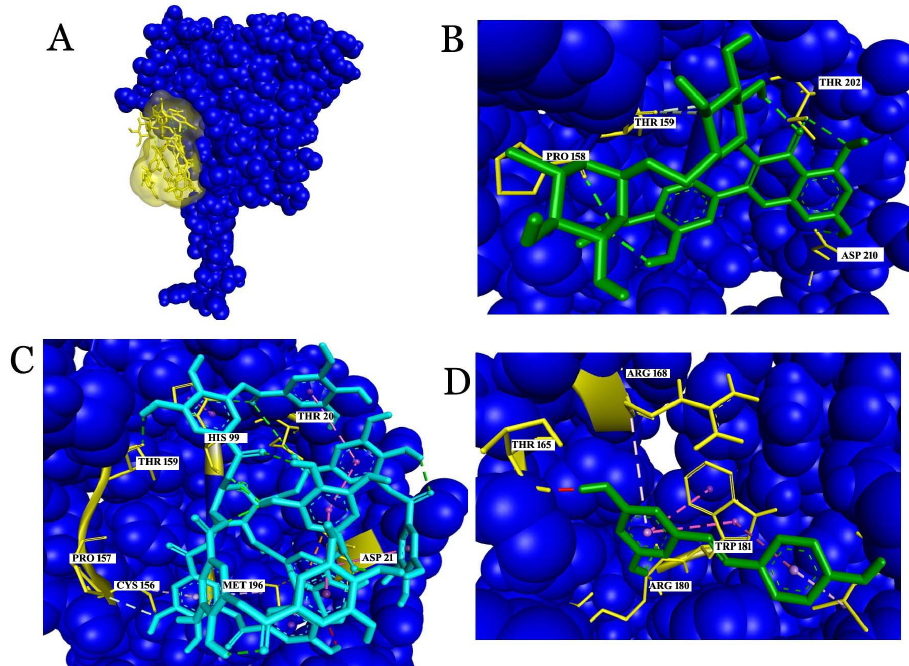
Figure 5. In silico docking of ligands into the binding pocket of human glutathione peroxidase 3 (GPX3). ( A ) CPK model of GPX3 protein, in which the yellow-colored surface represents the binding pocket; the expanded views of ligands interacting with the key amino acids of GPX3 (CPK model); ( B ) rutin; ( C ) tannic acid; ( D )